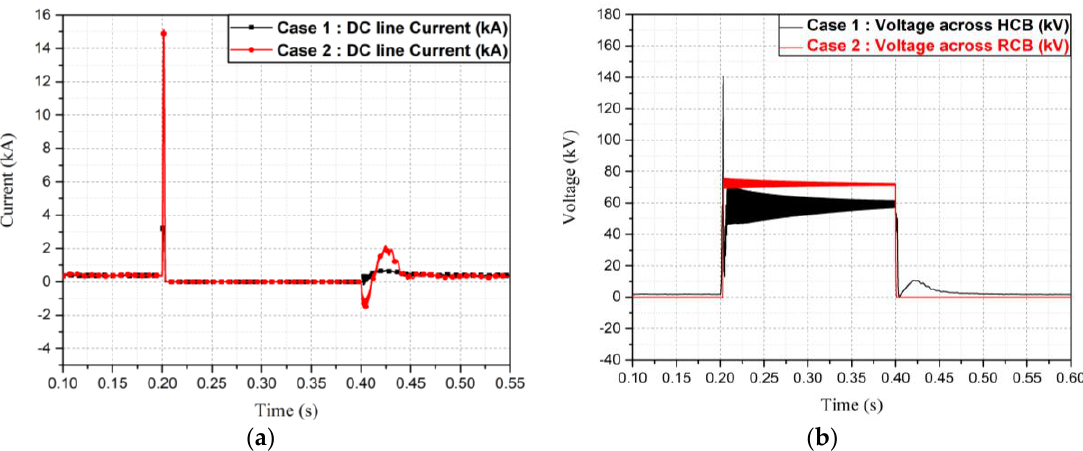
Figure 13. The waveform of the DC line current and voltage across the CB in the transient state: ( a ) the DC line current; ( b ) the voltage across the CB.